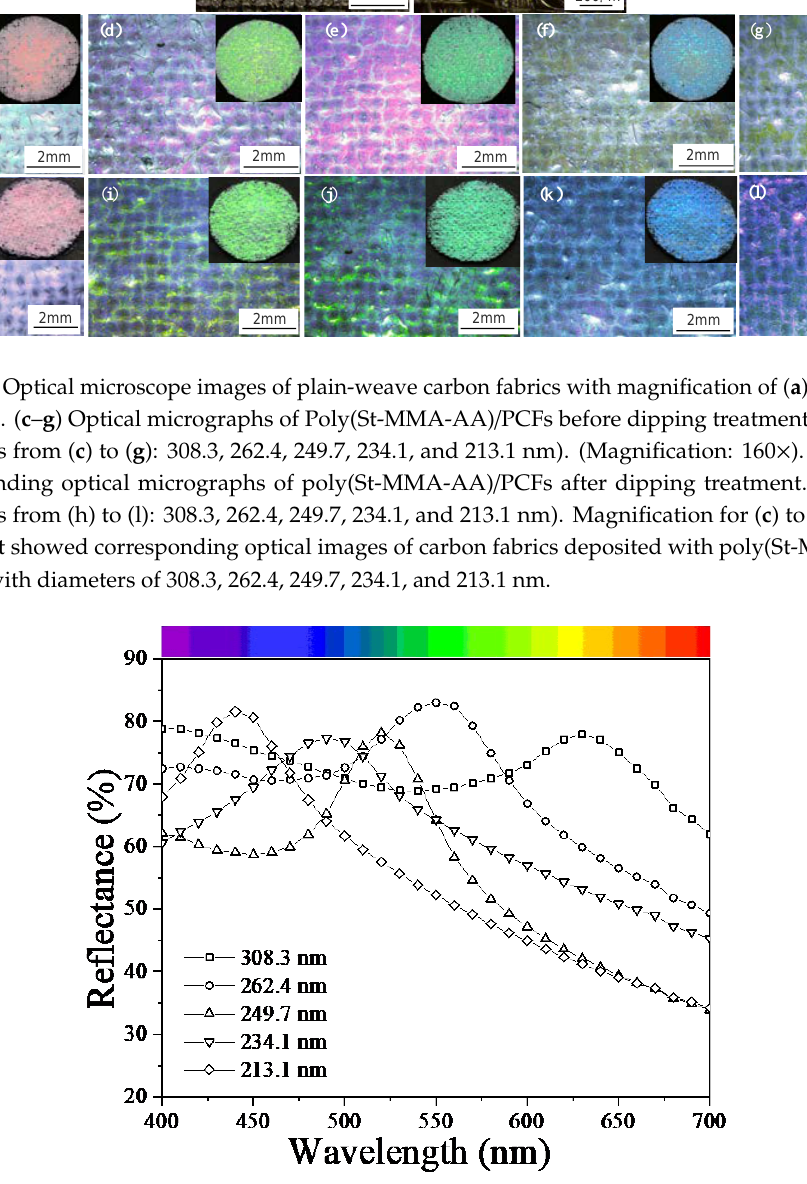
Figure 6. Reflectance spectra of Poly(St-MMA-AA)/PCFs showing different colours by the changes of Poly(St-MMA-AA) particle sizes (308.3, 262.4, 249.7, 234.1, and 213.1 nm).